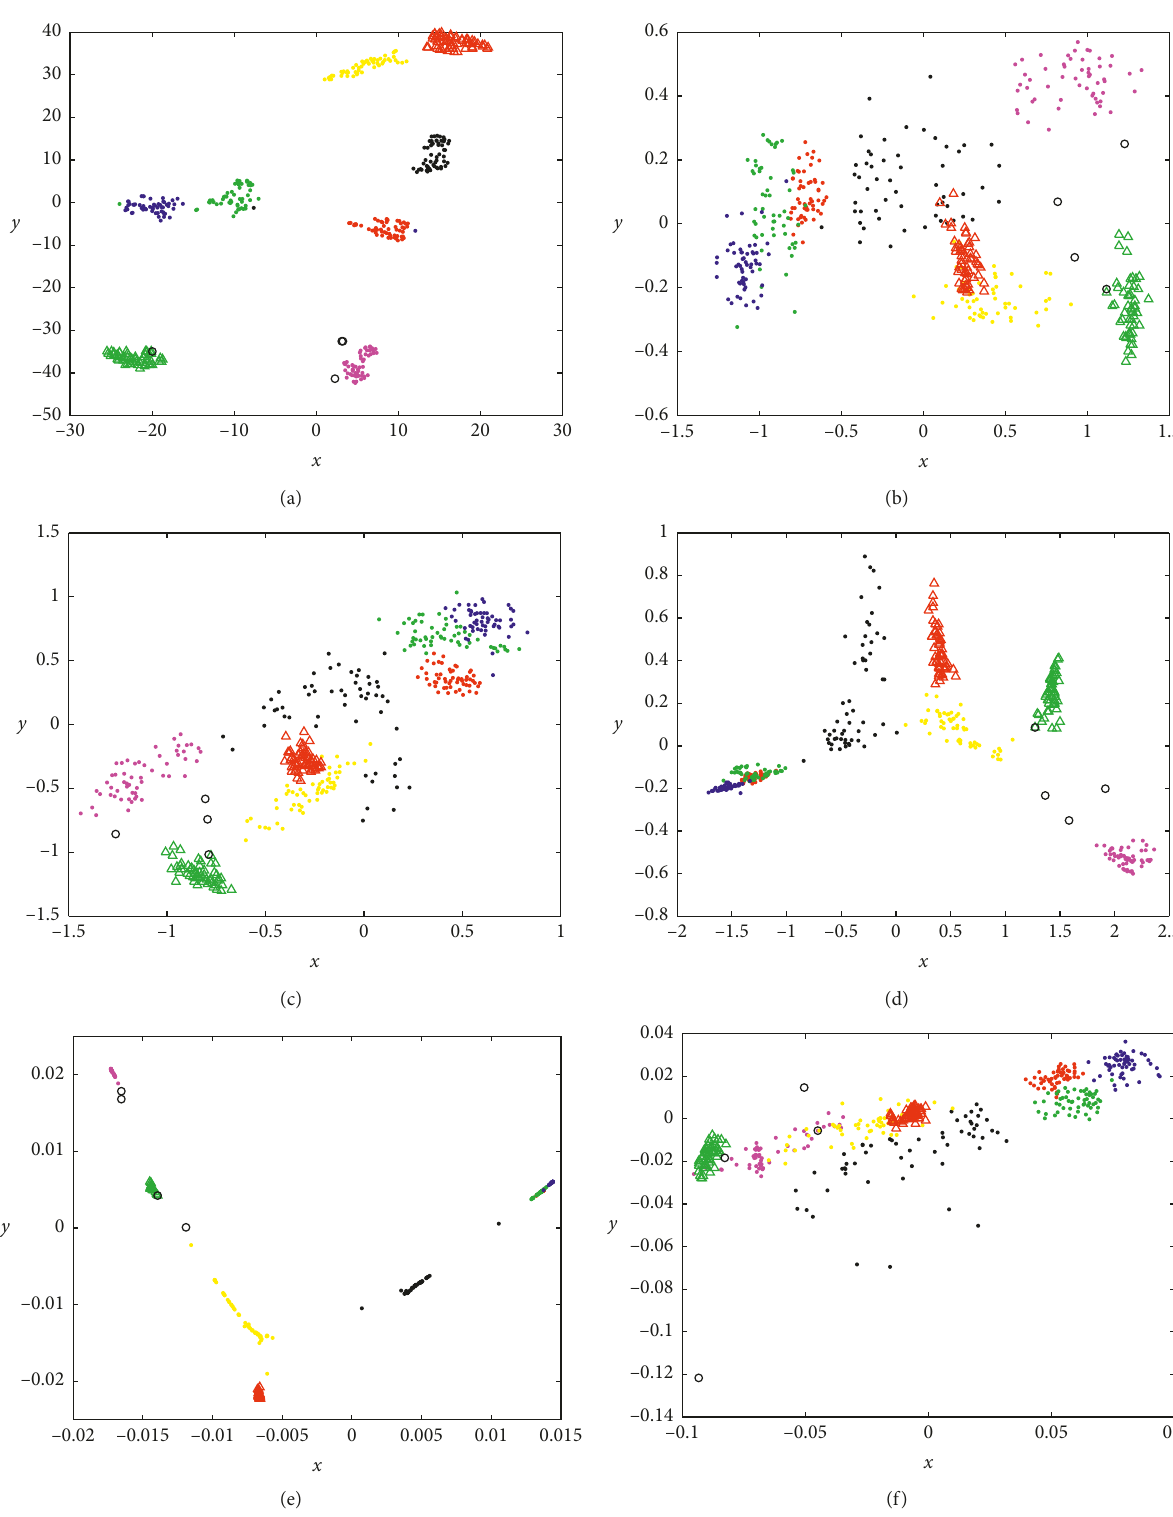
Figure 8: Comparison of secondary dimension reduction results: (a) t-SNE; (b) PCA; (c) SM; (d) IFM; (e) LE; and (f) can see that the performance of the t-SNE algorithm is the (LE) [18], and Linear Discriminator Analysis (LDA) [19] are best in view of the intraclass similarity and the interclass compared in Figure 8. In Figure 8, x -axis and y -axis refer to difference. the first two dimensions after dimension reduction, and we